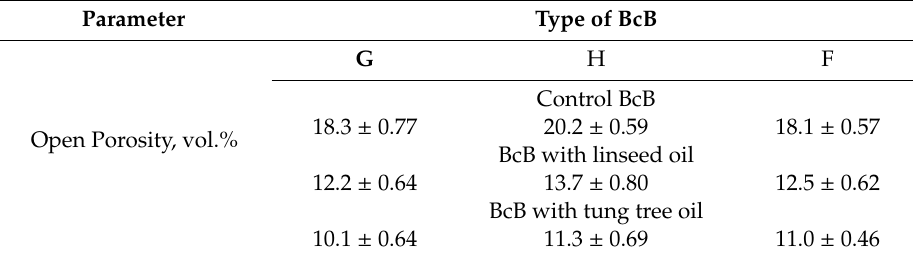
Table 6. Open porosity of di ff erent oil-impregnated BcBs at 90 ◦ C temperature. Table 6. Open porosity of different oil-impregnated BcBs at 90 °C temperature. Table 6. Open porosity of different oil-impregnated BcBs at 90 °C temperature. Table 6. Open porosity of different oil-impregnated BcBs at 90 °C temperature. Parameter Type of BcB Parameter Type of BcB Parameter Type of BcB Parameter Type of BcB Parameter Type of BcB Open Porosity, vol.% G Open Porosity, vol.% G H F Open Porosity, vol.% G H F Open Porosity, vol.% G H F Open Porosity,